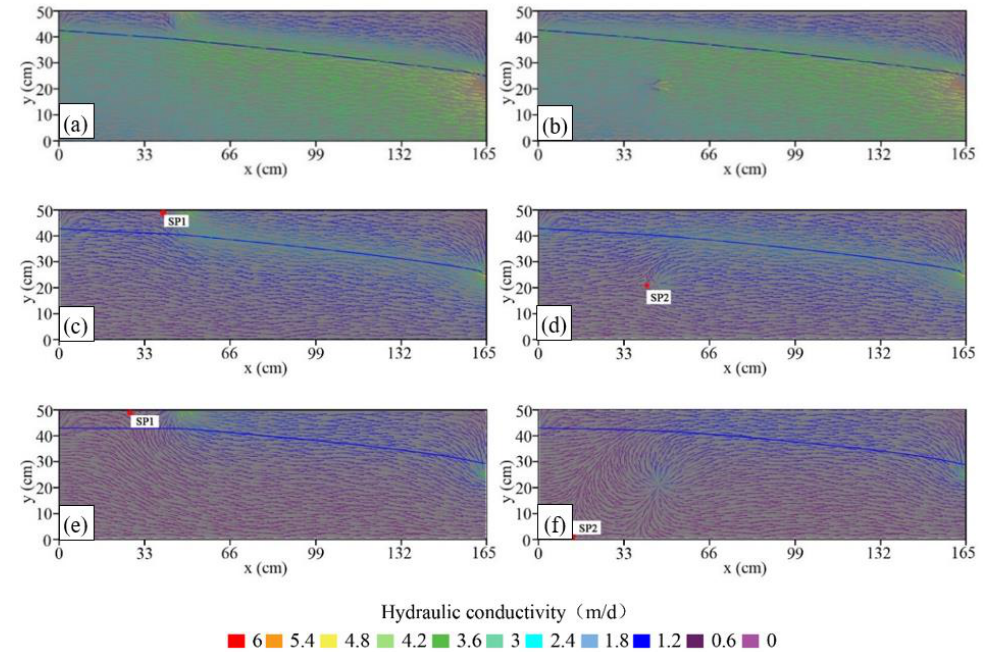
Figure 7. Flow fields when artificially recharged through the infiltration basin (left side figures) and injection well IW3 (right side figures) with different depth-decay exponents. The depth-decay exponents in ( a ) and ( b ) were set to 0.01 m −1 . The depth-decay exponents in ( c ) and ( d ) were set to 0.05 m −1 . The depth-decay exponents in ( e ) and ( f ) were set to 0.1 m −1 . The blue lines in the figures represent the water table.